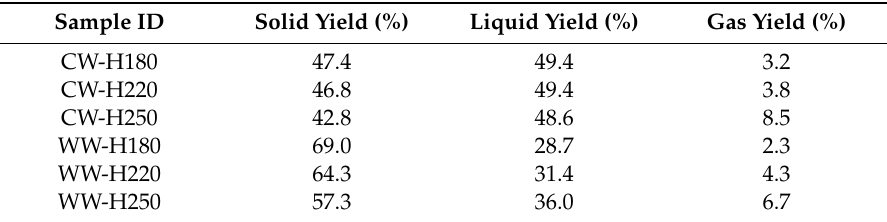
Table 1. Mass balance of hydrothermal carbonization (HTC) experiments.